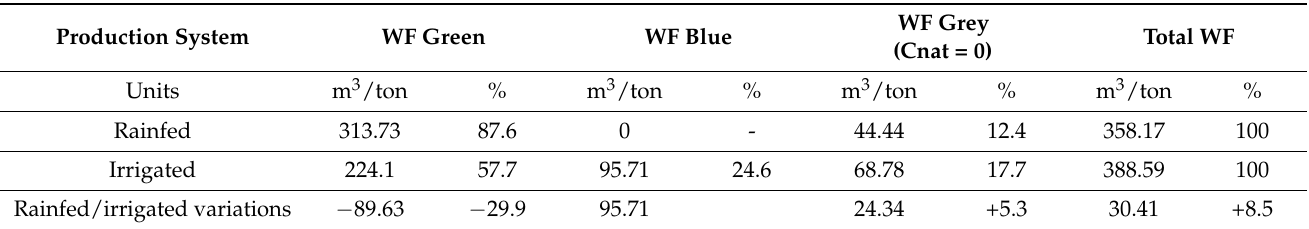
Table 4. Green, blue, and grey water footprint (WF) in rainfed and irrigated maize production, and variations between the two conditions in the Napaleof ú